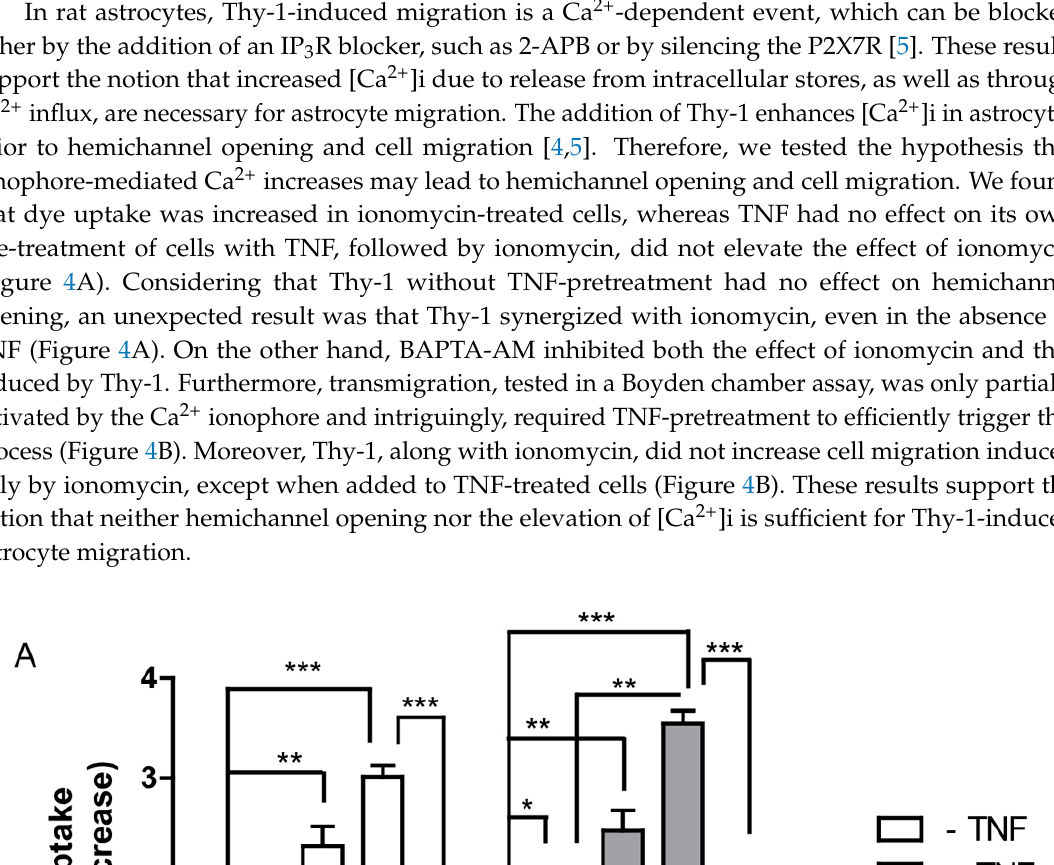
Figure 4. Hemichannel opening and ionomycin-induced intracellular calcium (Ca 2+ ) increase are necessary, but not sufficient, to promote Thy-1-induced cell migration. ( A ) Quantification of Lucifer yellow uptake by primary astrocytes pre-incubated with TNF (10 ng/mL for 48 h), BAPTA-AM (5 µM for 30 min) and then stimulated with Thy-1-Fc or ionomicyn (1 µM) for 10 min. Values in the graph correspond to the mean fluorescence intensity normalized to the non-stimulated condition; ( B ) Cell migration quantification of primary astrocytes incubated as indicated in ( A ). Cells were allowed to migrate for 2 h in inserts pre-coated on the lower side with fibronectin (2 µg/mL). Migrating cells were visualized by crystal violet staining of cells on the lower side of the inserts. Data were normalized to non-treated cells and are shown as the average of 7 different fields from each independent experiment, n = 3, ns = non-significant, * p < 0.05, ** p < 0.01, *** p < 0.001. Solid lines indicate comparisons of pairs under the same experimental conditions, i.e. − TNF or +TNF. Dashed lines are comparisons of pairs between experimental conditions, i.e. between − TNF or +TNF. 2.4. Hemichannel Opening and [Ca 2+ ]i Increases Are Necessary, but Not Sufficient to Promote Cell Migration In rat astrocytes, Thy-1-induced migration is a Ca 2+ -dependent event, which can be blocked either by the addition of an IP 3 R blocker, such as 2-APB or by silencing the P2X7R [5]. These results